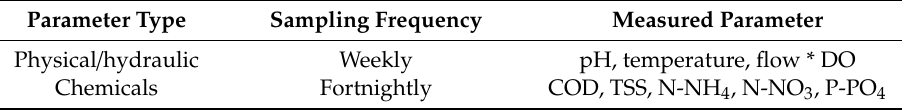
Figure 2. Materials used as filter media in the constructed wetlands (CWs) in this study. Table 1. Measured parameters according to standard